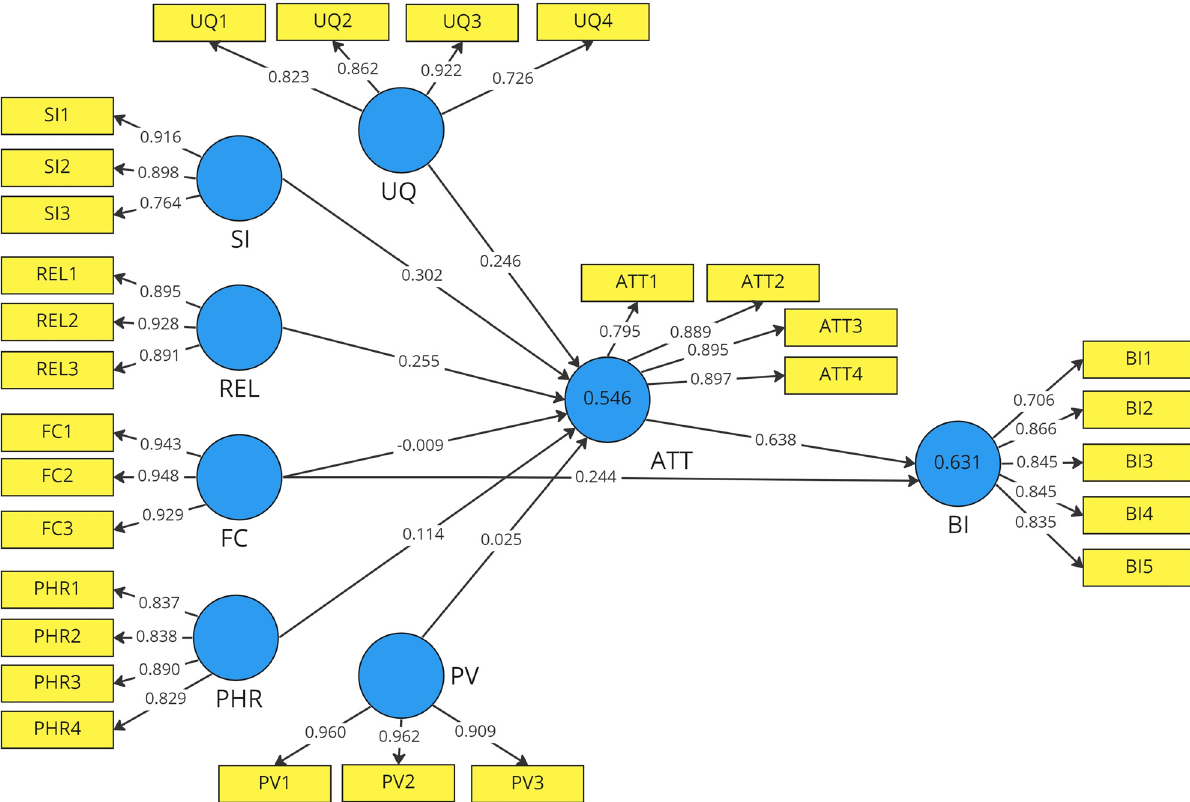
Figure 3: Output of the research model from